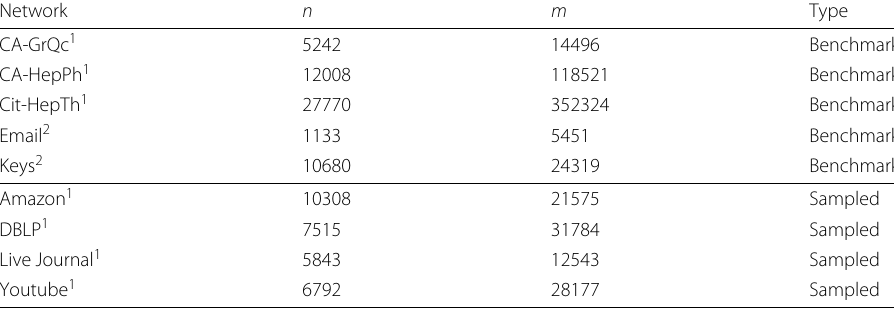
Table 1 Real-world network considered in this work Network